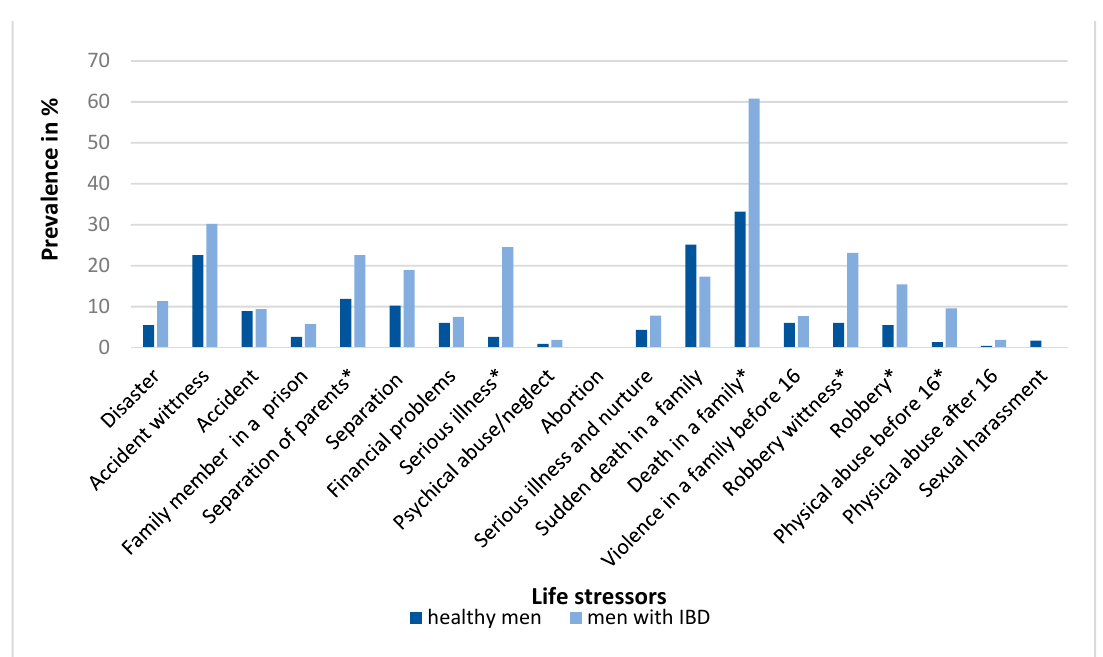
Figure 2. Prevalence of life stressors (%) in the healthy control group (HC, N = 405) and in patients with inflammatory bowel disease (IBD, N = 98). Differences in the occurrence of individual life stressors between the groups were assessed by a test of proportions (Z-test); * p < 0.05. Life stressors with low prevalence are not presented.